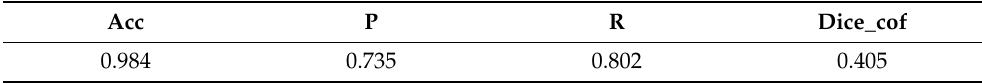
Figure 16. The visual results of the second model for cancer detection on 3D-IRCADb-01 dataset: ( a ) normal case (no tumor detection); ( b ) abnormal case (tumor detection). The overall performance based on the metrics is shown in Table 4. Table 4. The overall performance of the second model on 3D-IRCADb-01 dataset.